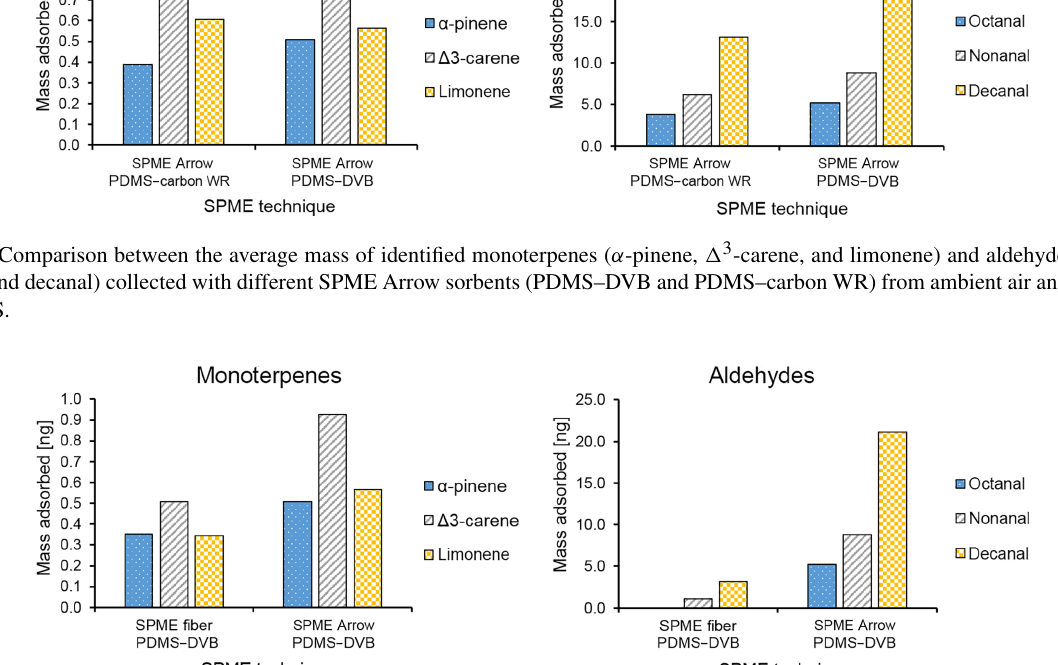
coating are more susceptible to displacement effects